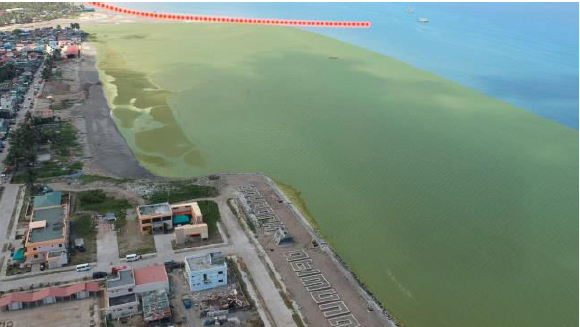
Figure 4 . Aerial photo of the study area. Yellow area highlights the accumulation of sand